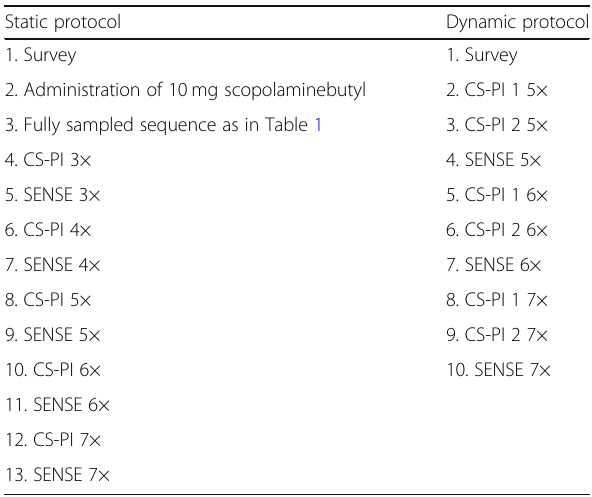
Table 2 MRI protocols and acquisition order of the